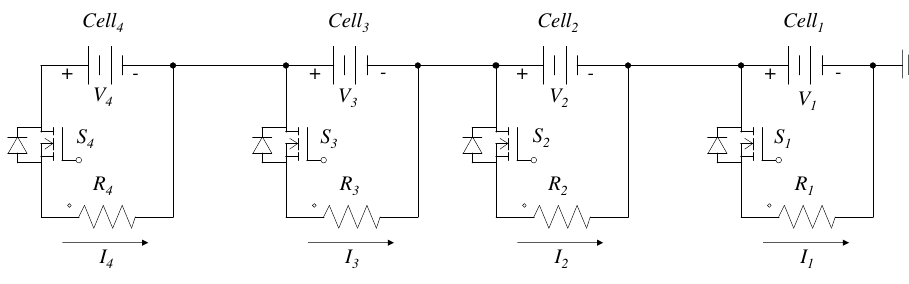
Figure 3. Switched resistor equalizer scheme.